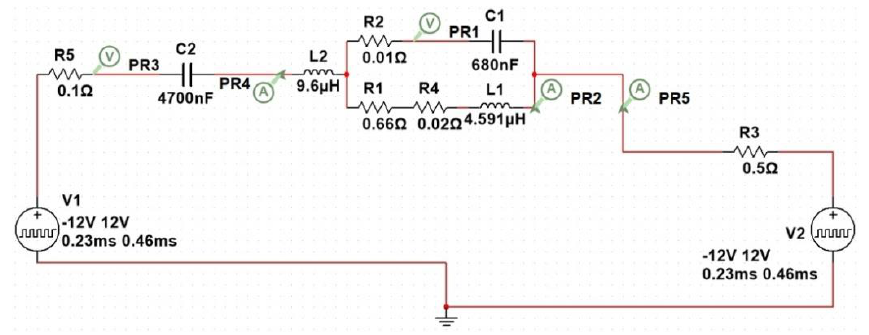
Figure 4. Multisim model of LCL series-parallel resonant circuit.